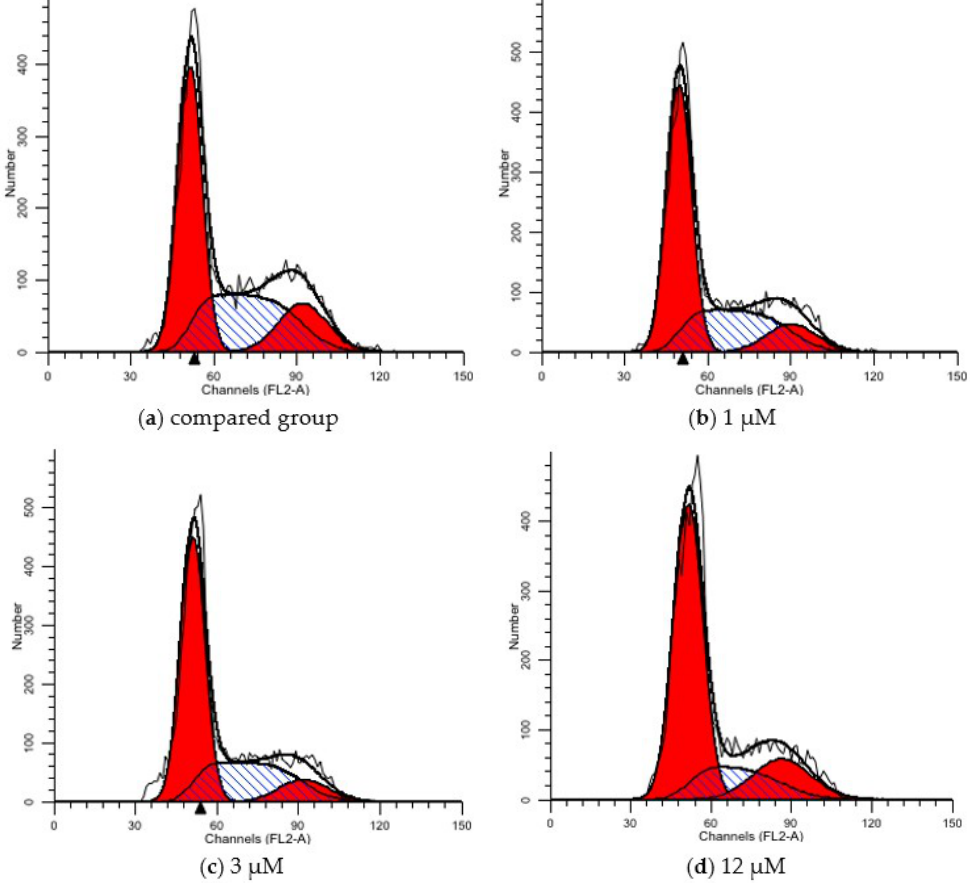
Figure 5. Different concentration of compound 4 of ( a ) compared group, ( b ) 1 µ M, ( c ) 3 µ M and ( d ) 12 µ M effect on the HepG2 cell cycle of humans. x -axis: Channels (FL2-A); y -axis: Number. Red zone from left to right: Dip G1 and G2; middle blue cross-court zone: Dip S.